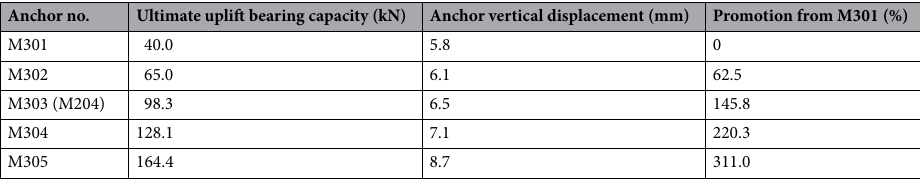
Table 8. Ultimate uplift bearing capacities and vertical displacements of group M3.